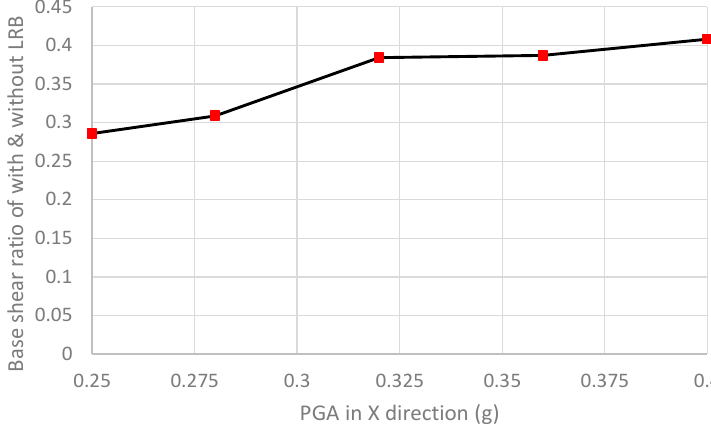
Figure 8. The base shear ratio changing with PGA under T s of 0.6 s.